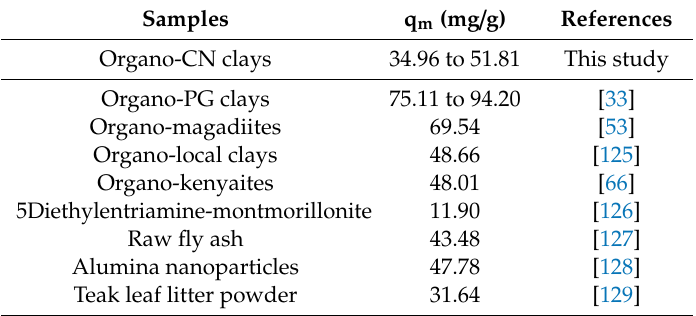
Table 6. Removal capacities of various adsorbents for eosin dye.